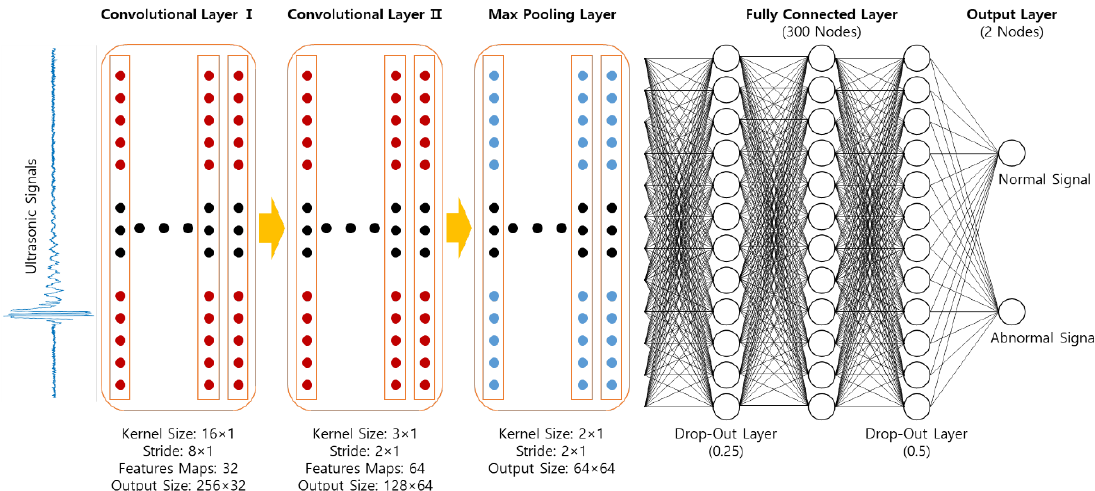
Figure 8. Architecture of the convolutional neural network applied [17].